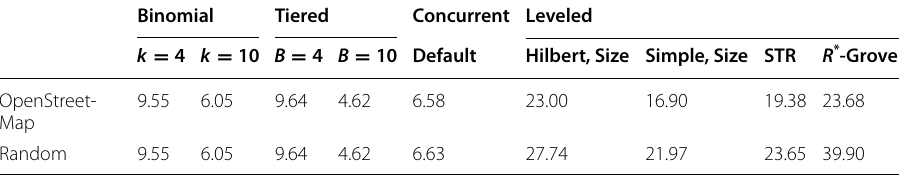
Table 3 Overall write amplification of compared policies. Binomial Tiered Concurrent